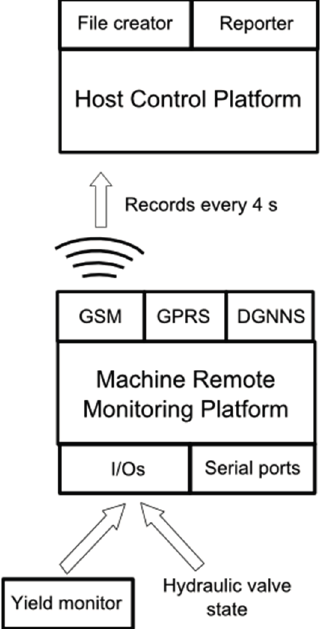
Figure 1. Hardware scheme of a remote wireless automatic monitoring system. Data transmission and communication between agricultural vehicles and expertise